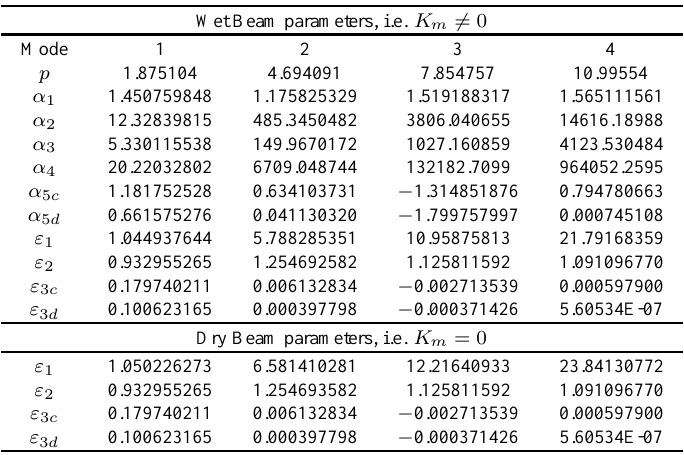
Table 1 Values of the parameters in the temporal equation (25) of the beam system shown in Fig. 1 with physical characteristics as described in Section (4), for the first four lineareigenfunctionsofthecantileverbeam. Wherethesubscript c corresponding to the concentrated load and the subscript d corresponding to the distributed load.